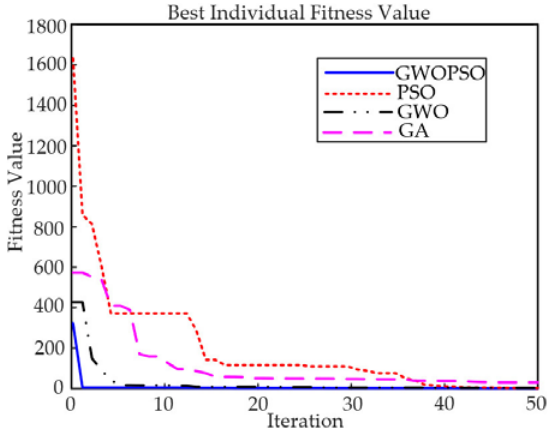
Figure 11. The ITAE iteration curves under slow-varying load. Table 7. PID parameters and dynamic response characteristic.